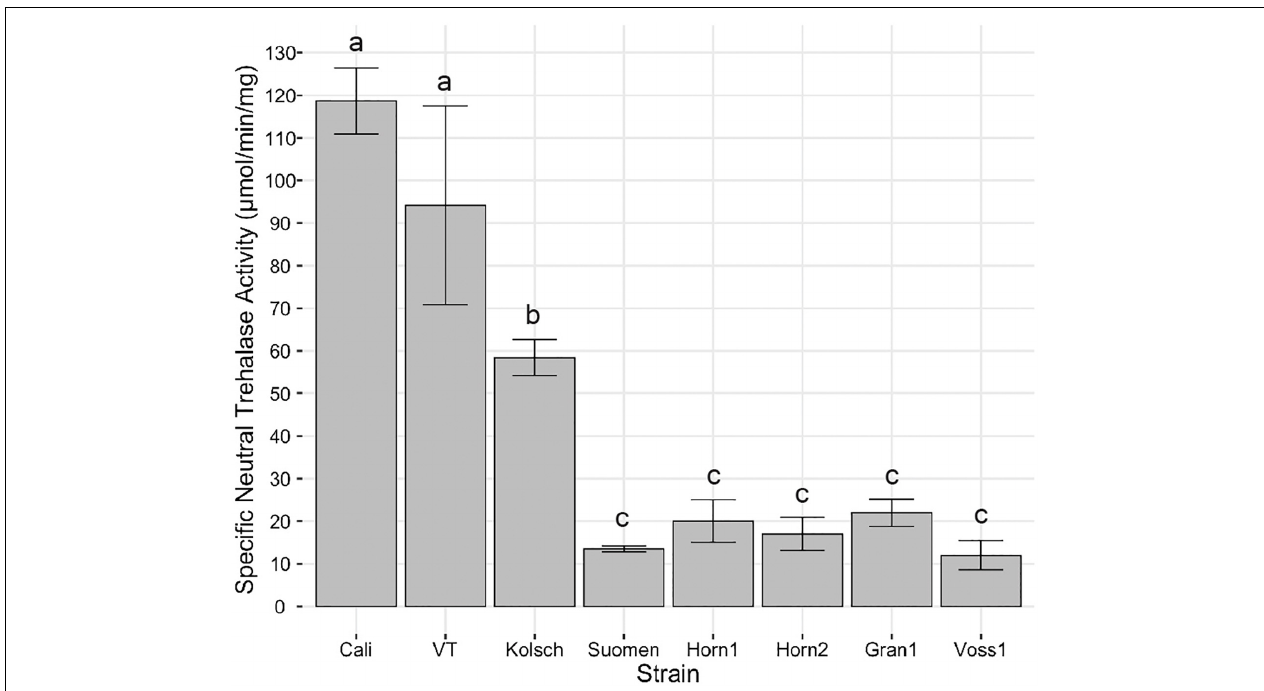
FIGURE 10 | Analysis of specific neutral trehalase activity. Single colonies were inoculated into 100 mL of YPD and incubated at 30 ◦ C with shaking at 170 rpm until 2 h post-diauxic shift. Cell samples were collected and trehalase activity assays performed as described in Methods. Specific activity of trehalase is expressed as µ mol of glucose liberated per min per mg protein. Data points represent the mean of biological replicates ( n = 3) and error bars represent the standard deviation. Data was subjected to one-way ANOVA followed by Tukey’s HSD analysis of the mean specific neutral trehalase activity between strains (Trehalase Activity ∼ Strain). Mean values assigned with a common letter are not significantly different by the HSD-test at the 5% level of significance.